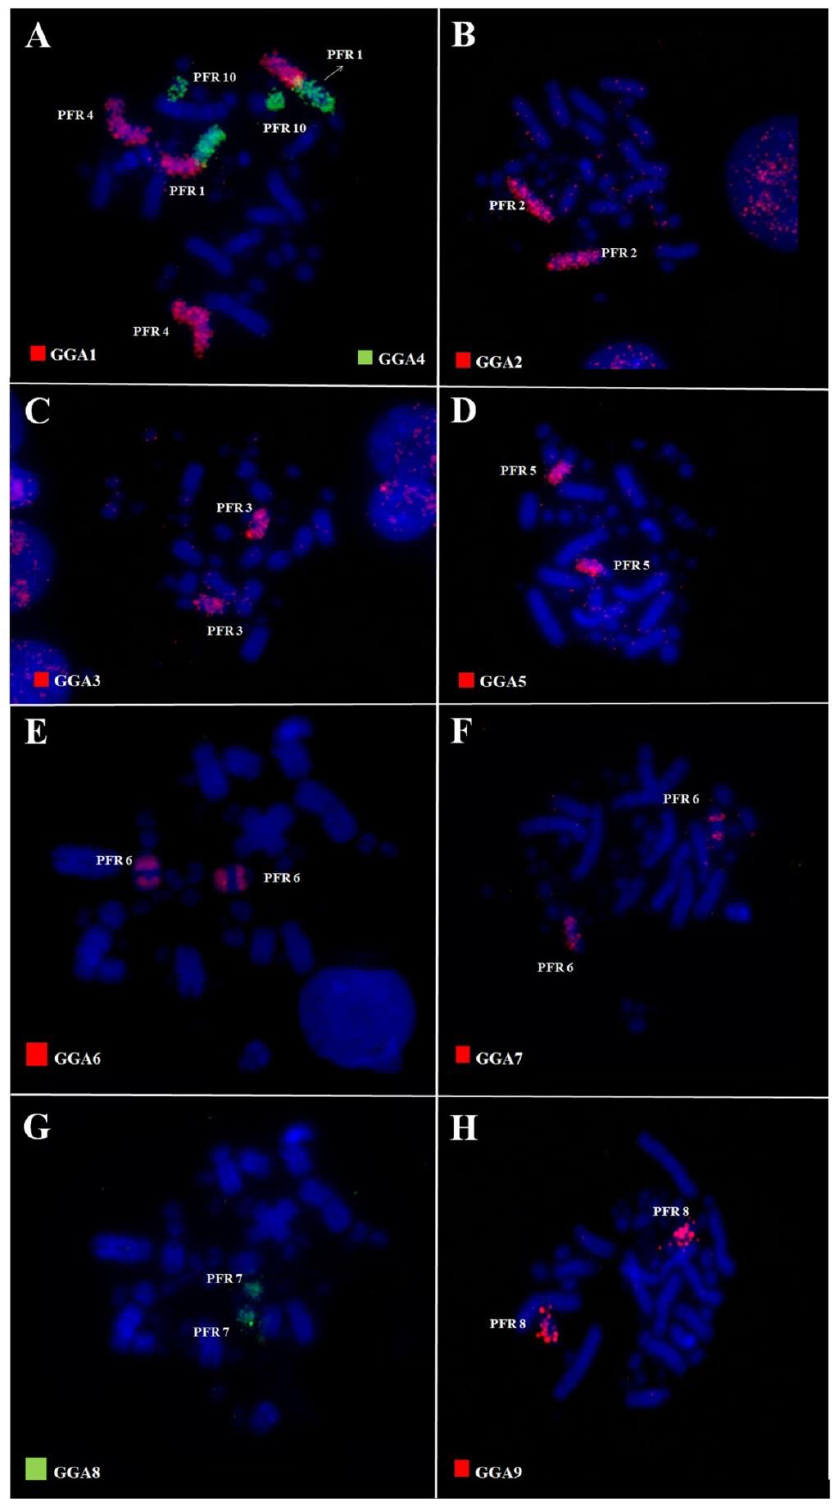
Figure 2. Fluorescent in situ hybridization (FISH) using whole-chromosome probes of Gallus gallus 1–9 in P . frontalis . GGA: Gallus gallus ; PFR: Pyrrhura frontalis .